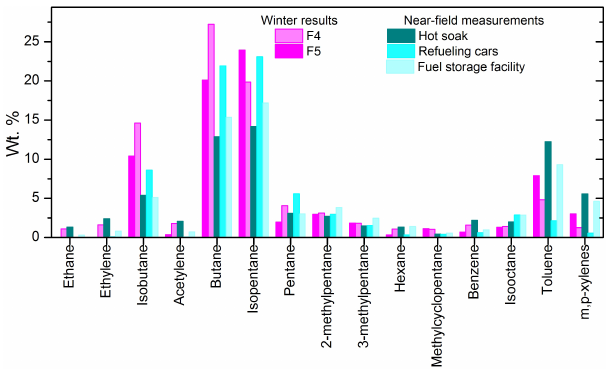
Figure 4. Composition profiles (wt%) of two gasoline evaporation factors (F4 and F5) in winter compared to typical gasoline evapo- ration profiles established by near-field measurements (Salameh et al.,